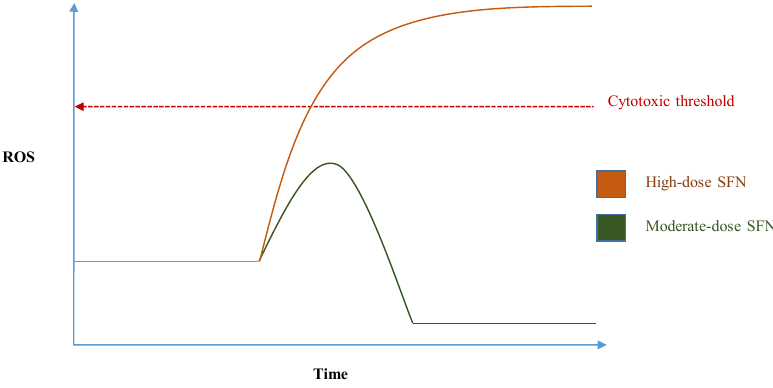
Figure 3. A sketch illustrating the hormetic effects of sulforaphane on cells with regards to oxidative stress, in that net reduction of oxidative stress is observed upon exposure to moderate doses, whereas increased oxidative stress and/or cytotoxicity occurs from high exposure.